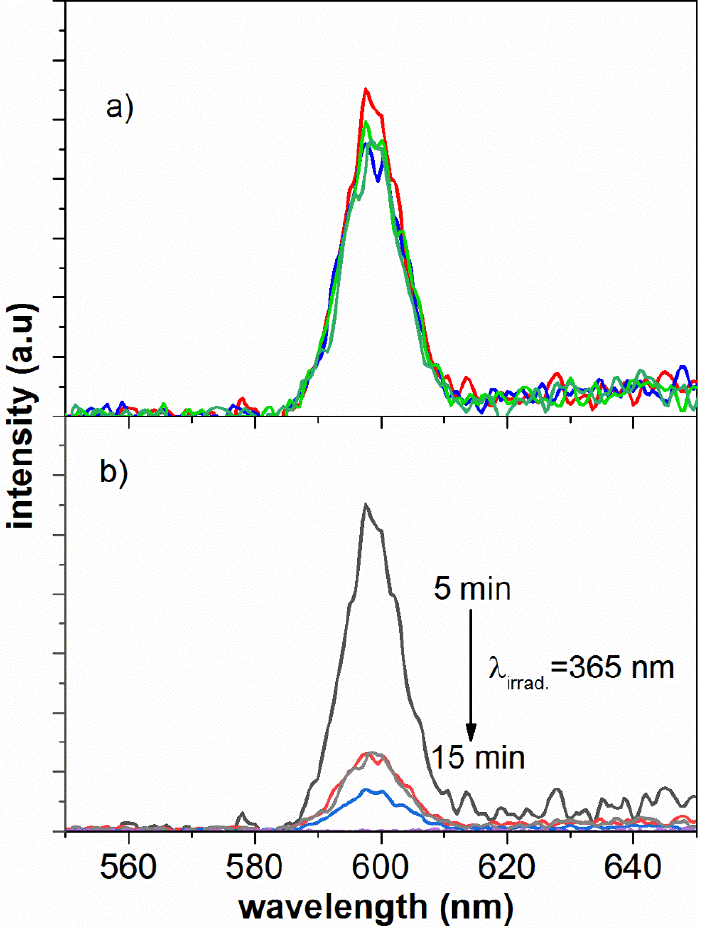
Figure 7. Emission spectrum of an acetonitrile solution of PS- b -PMMA- SP ( a ) 5, 10 and 15 min after ultraviolet irradiation and ( b ) PS- b -PMMA- SP - ZnS (NPs) ( λ Ex = 320 nm) after ultraviolet irradiation (365 nm, 0.4 mW cm − 2 for 5 min, photoactive polymer alone (black line) and PS- b -PMMA- SP - ZnS NPs for 5, 10 and 15 min after ultraviolet irradiation (c = 5% w/w ).